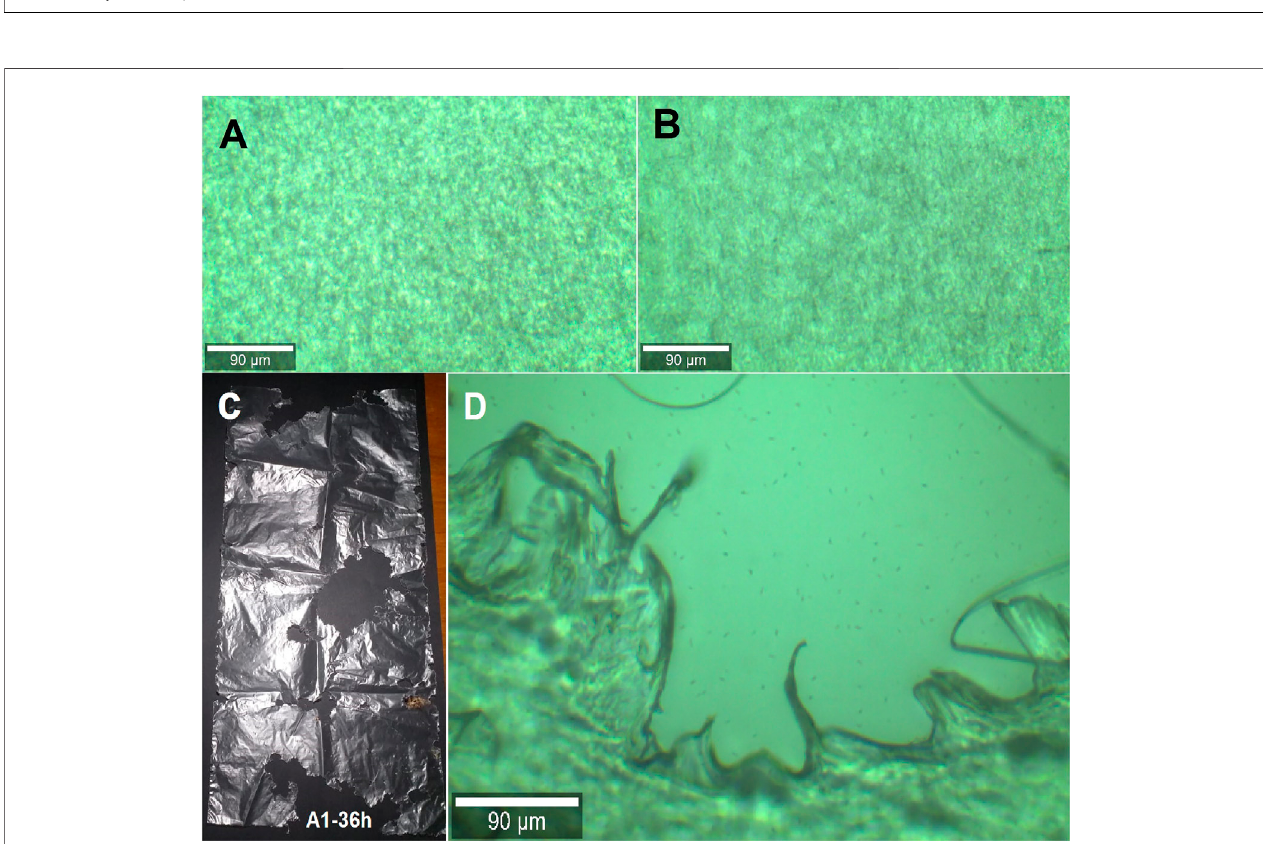
FIGURE7| ResultofthephysicalchangeoftheLDPE.In (A) ,theopticalmicrographofthecontrolsampleisobservedandin (B) ,theA1-36 htreatment; (C) shows the evidence of LDPE consumption of the A1-36 h treatment with a normal scale view, and (D) presents a light micrograph view of sample A1-36 h-a2.